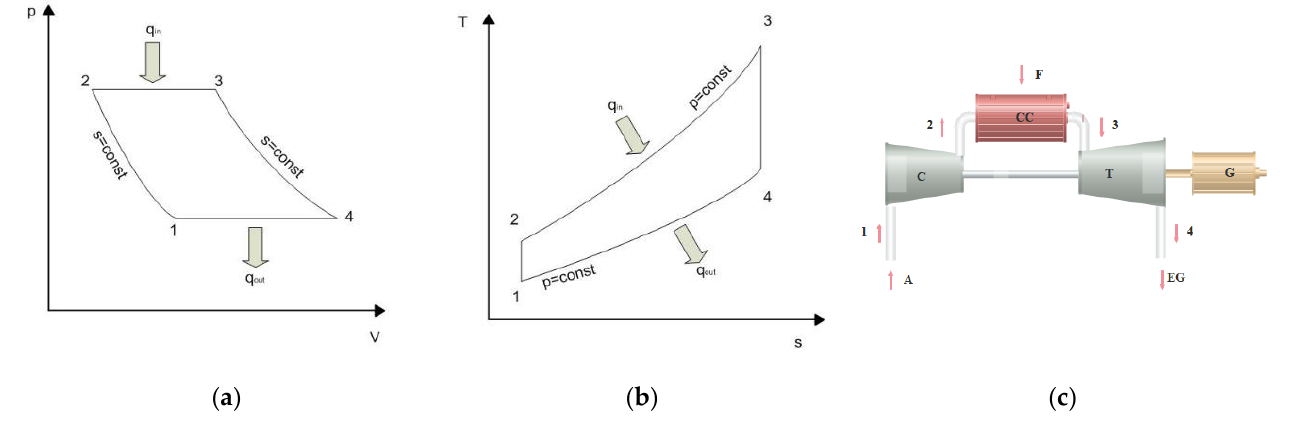
Figure 2. ( a ). Brayton’s cycle in the p -V plot. ( b ). Brayton cycle in a T-s plot. ( c ). General scheme of a gas turbine (A: air; C: compressor; CC: combustion chamber; F: fuel; T: expander; G: generator; EG: exhaust gas).